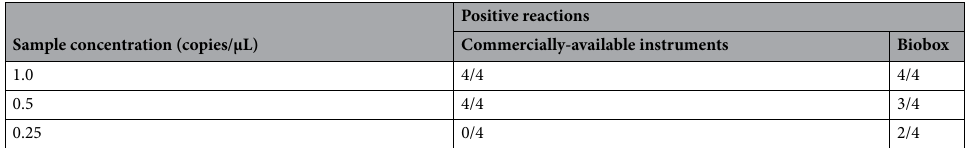
Table 1. Limit of detection determined by dilution series for Saliva-Dry LAMP using commercially-available instruments and the Biobox manufactured in this study. A single experiment performed in quadruplicate is shown at each concentration using a contrived saliva sample containing SARS-CoV-2.